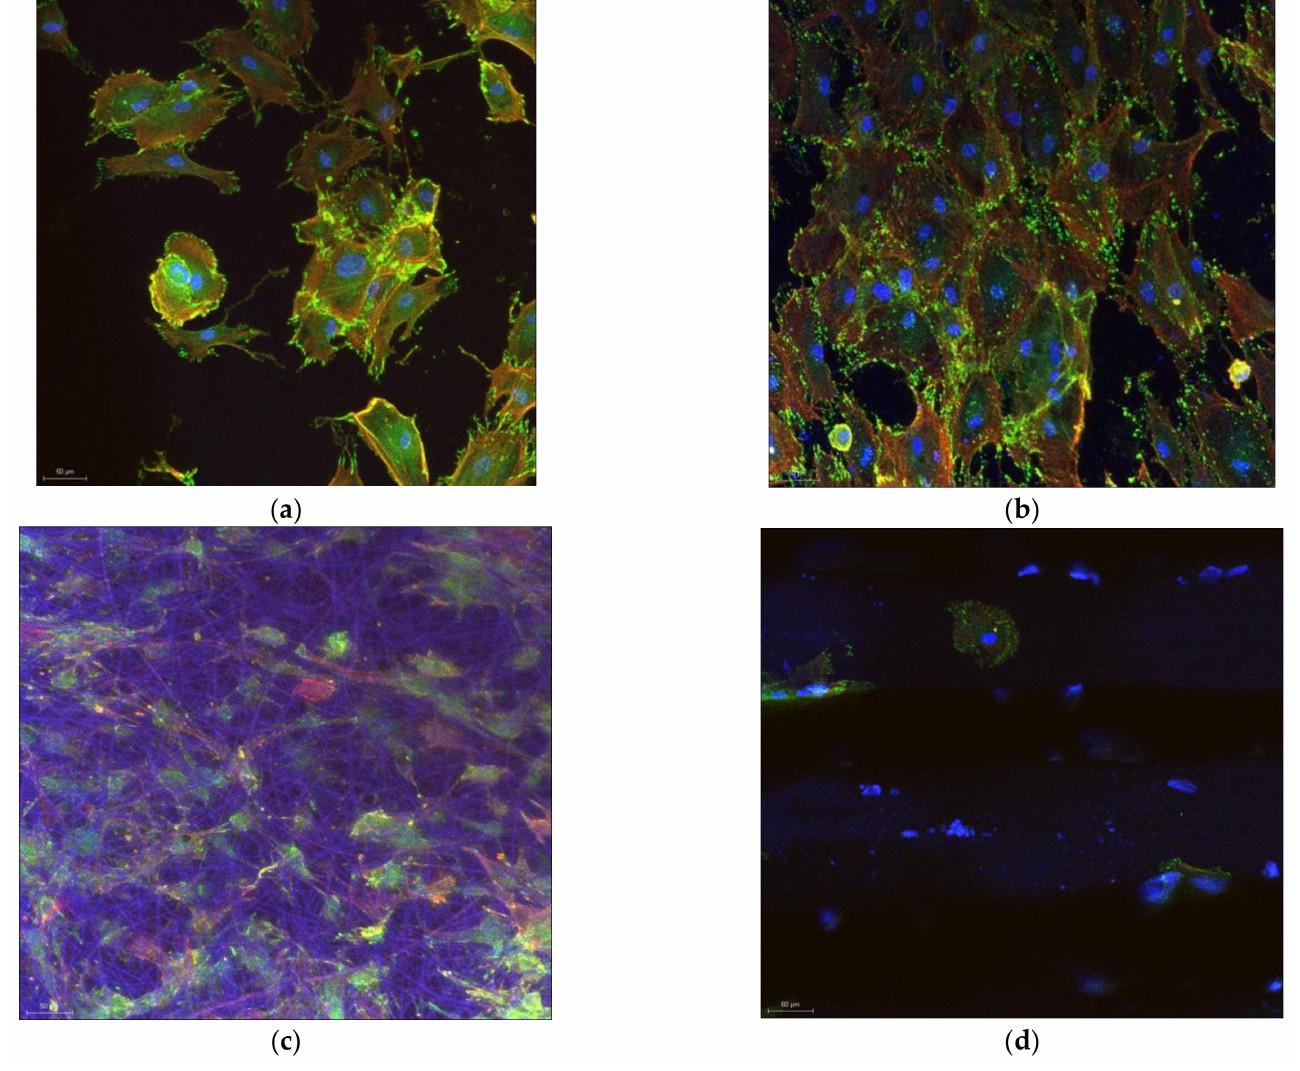
Figure 10. Confocal images of osteoblasts on the substrates after 1 days of incubation